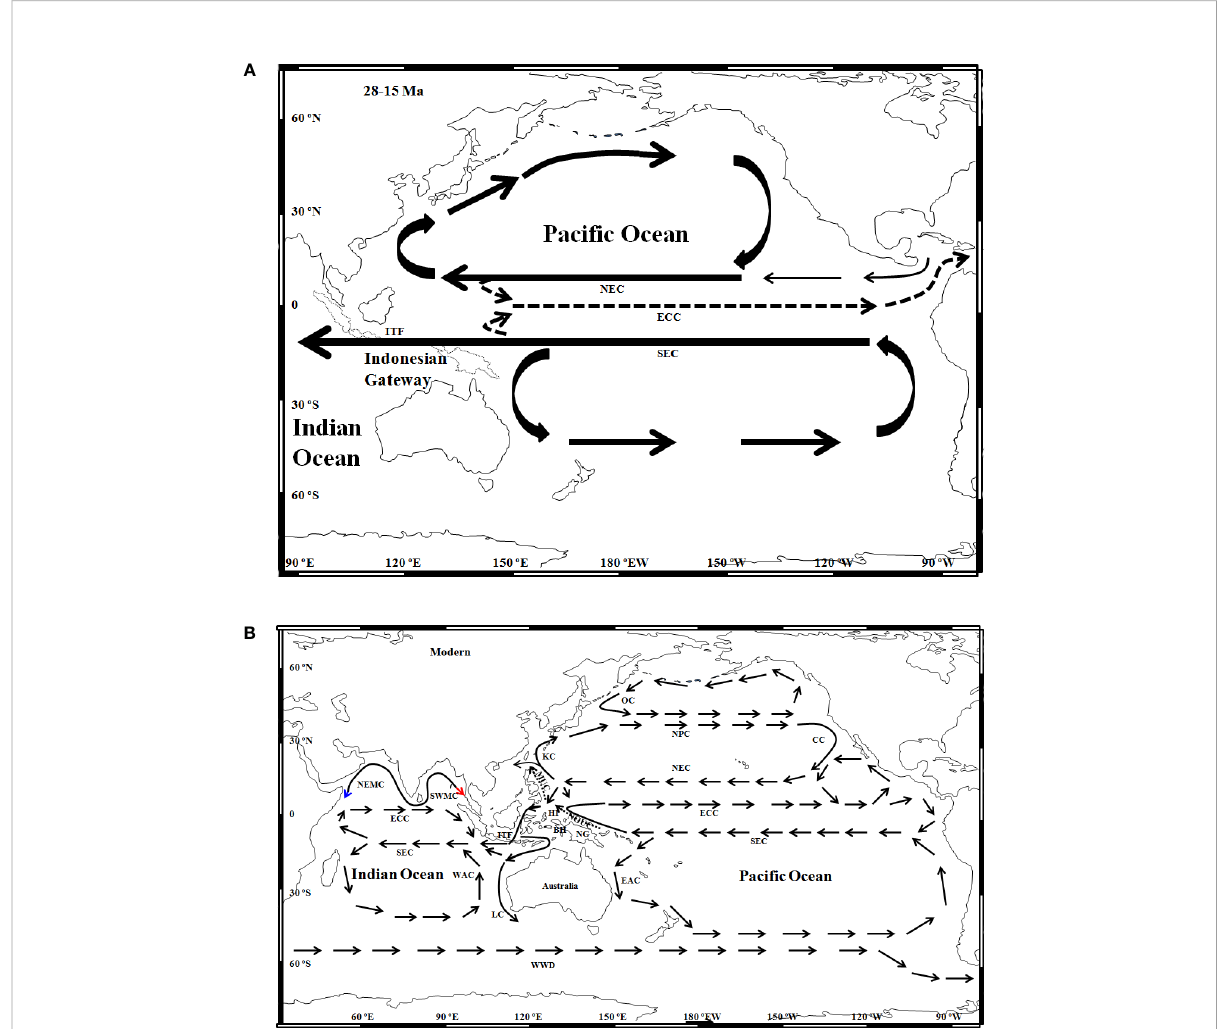
FIGURE 6 Circulation patterns in the Indo-Paci fi c Ocean during (A) the late Oligocene – Early Miocene (modi fi ed from Kennett et al., 1985; Sclater et al., 1985; von der Heydt and Dijkstra, 2006) and (B) modern (modi fi ed from Prell et al., 1980; Pollock, 1990; Pollock, 1992; Lukas et al., 1996; Morey et al., 1999; Kuhnt et al., 2004). BH, Bird Head; CC, California Current; EAC, East Australia Current; ECC, Equatorial Countercurrent; HI, Halmahera Island; ITF, Indonesian Through fl ow; KC, Kuroshio Current; LC, Leeuwin Current; MUC, Mindanao Undercurrent; NG, New Guinea; NGUC, New Guinea Undercurrent; NEC, North Equatorial Current; NPC, North Paci fi c Current; NEMC, Northeast Monsoon Current; OC, Oyashio Current; SEC, South Equatorial Current; SWMC, Southwest Monsoon Current; WAC, West Australia Current; WWD, West Wind Drift. Blue and red arrows indicate directions of Northeast Monsoon circulation and Southwest Monsoon circulation, respectively. Dotted lines indicate